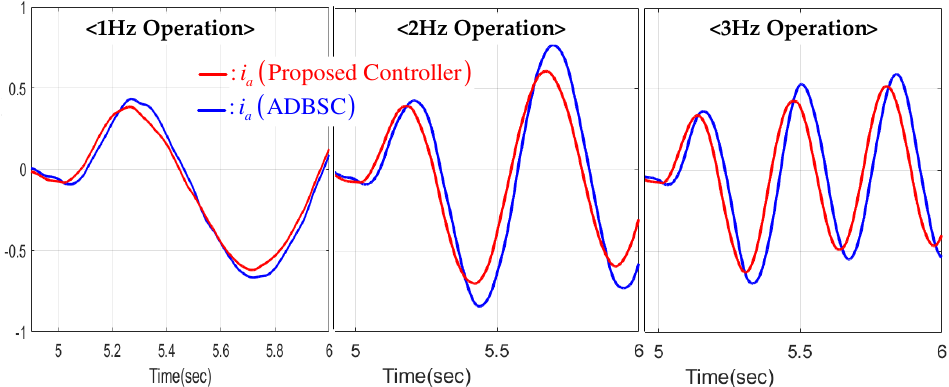
Figure 7. Comparison of stator current responses for increasing sinusoidal speed references of 1, 2 and 3